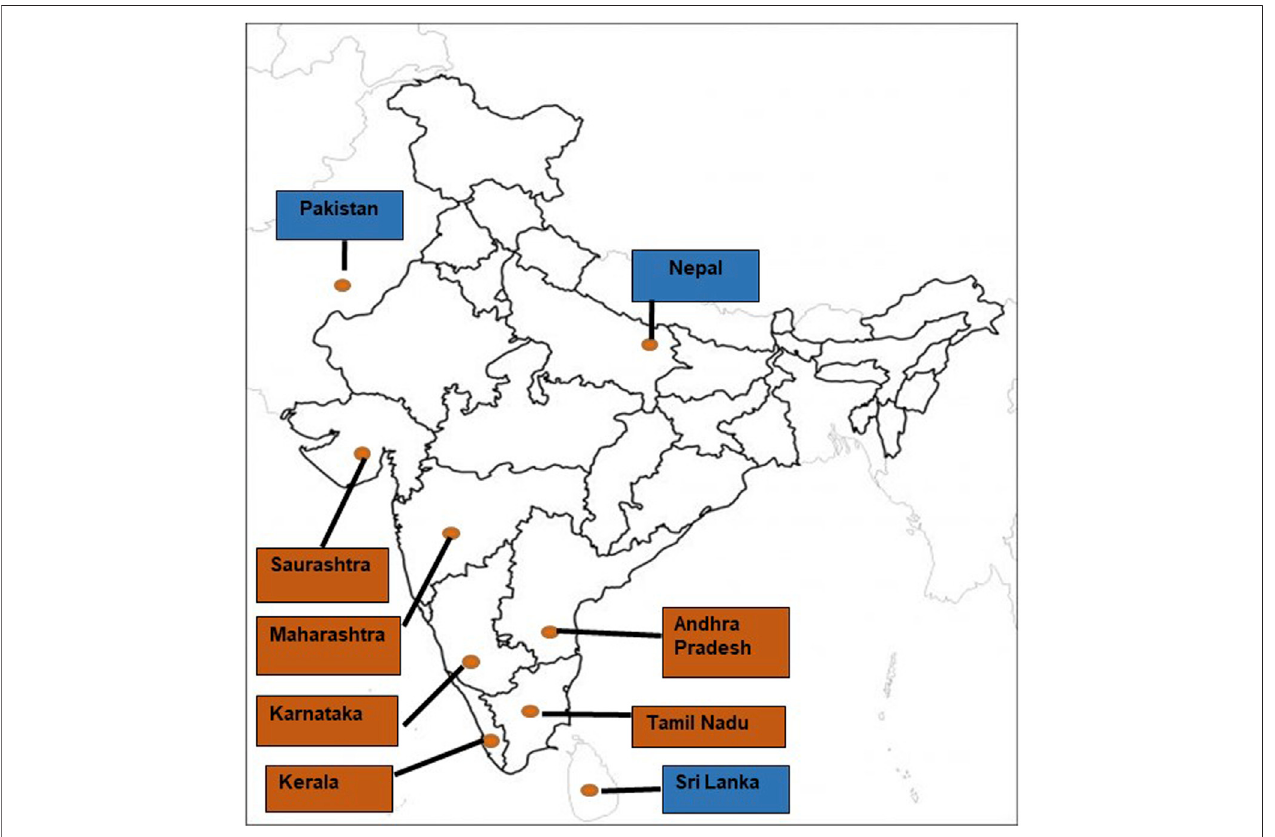
FIGURE2| ThegeographicaldistributionoftheIndianredscorpionthroughouttheIndiansub-continent[Brown fi ll:Indianstates;Blue fi ll:neighbouringcountriesof India].